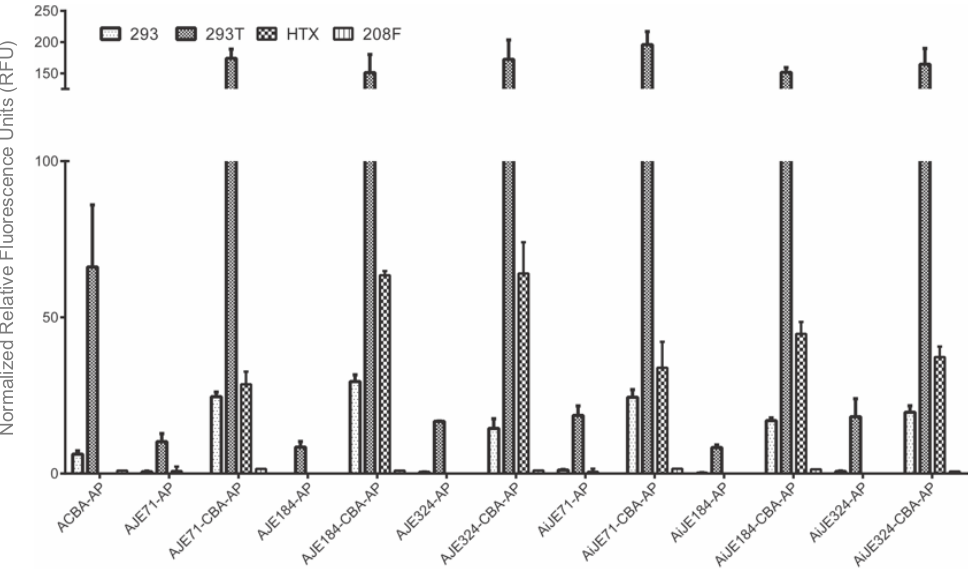
Figure 2. Transfection of four di ff erent cell lines (human embryonic kidney (HEK) 293, HEK 293T, rat fibroblast (208F), and human fibrosarcoma (HTX)) with various constructs incorporating the normal orientation JE or the inverted JE. The presence of the inverted JE is denoted by an “i”. Three di ff erent sizes were compared corresponding to JE sequences 71, 184, or 324 bp in length. These inverted and non-inverted JE sequences were either placed on their own, or in front of the chicken beta actin promoter to determine if the JE could function as a promoter, or in conjunction with a heterologous promoter (chicken beta actin promoter) as an enhancer. The chicken beta actin promoter was also transfected to indicate a baseline level of expression. Normalized Relative Fluorescence Units (RFU) are reported, where AP activity was normalized to β -galactosidase activity. Experiments were conducted in triplicate with three biological